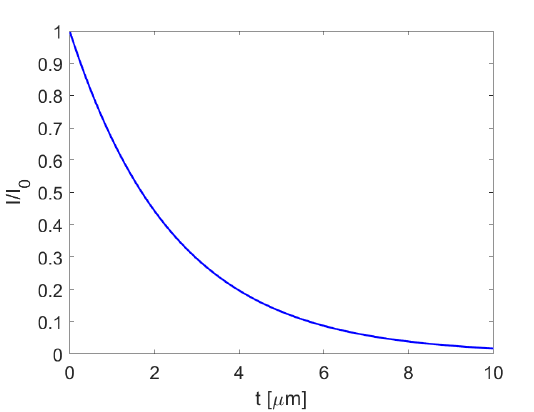
Figure 5. Attenuation of the 1 keV X-ray in liquid water.